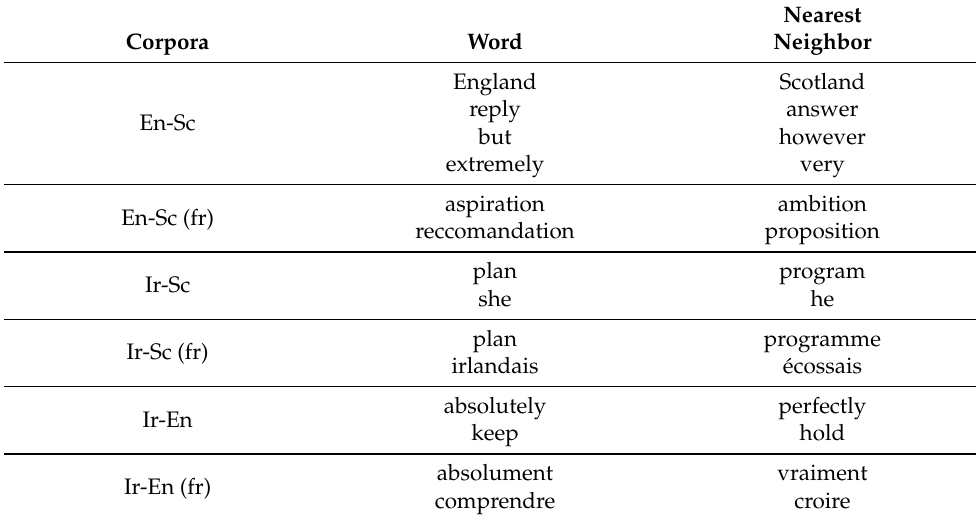
Table 7. Examples of unmatched